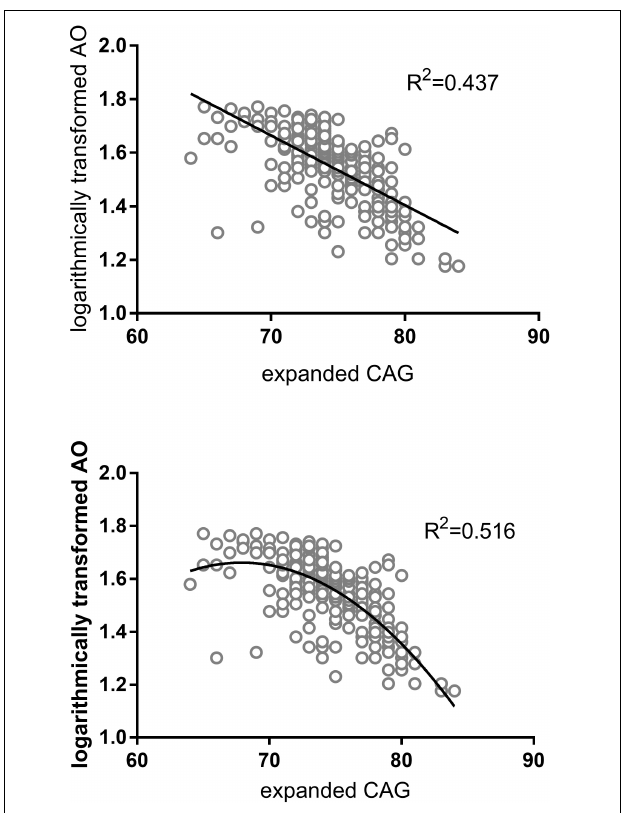
FIGURE 1 | AO attributed to abnormal CAG repeats in ATXN3 of MJD patients. The figures on the above and below are regression analyses in linear and quadratic models, respectively. The X-axis denotes the expanded CAG repeat length, and the Y-axis indicates the logarithmically transformed AO. AO of MJD patients was inversely correlated with the length of expanded CAG repeats in the ATXN3 gene.